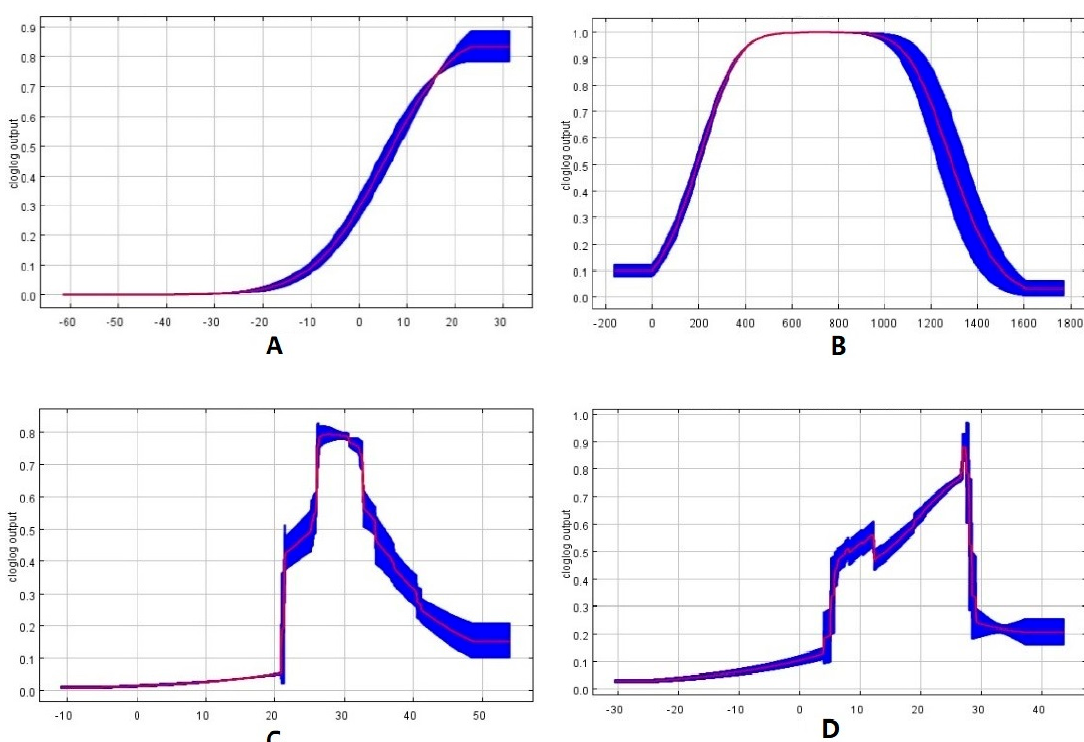
Figure 4. Response curves between probability of presence and environmental variables (Values shown are average over 10 replicate runs: blue margins show ± SD calculated over 10 replicates).( A ) bio6; ( B ) bio13; ( C ) bio5; ( D ) bio8.